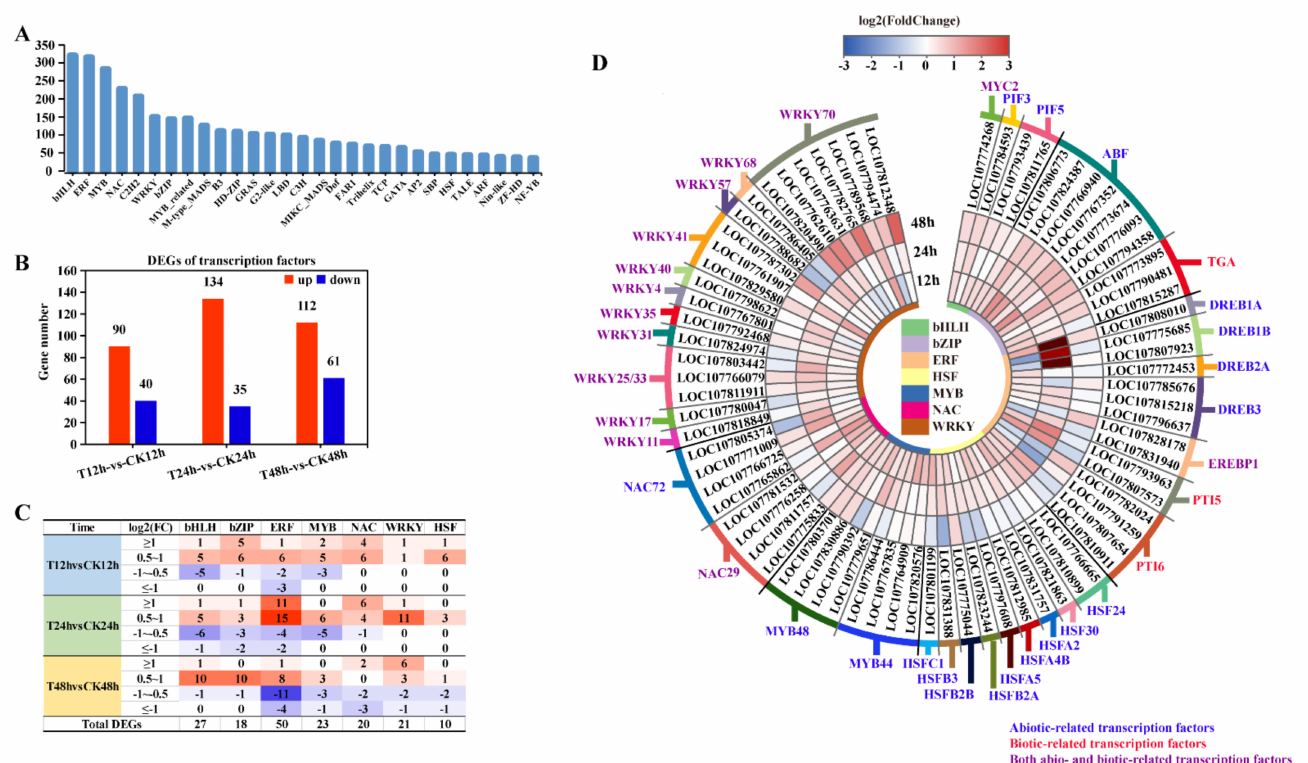
Figure 7. The expression of transcription factors that responded to 1 (cid:48) ,4 (cid:48) - trans -diol-ABA treatment at different time points. ( A )The TF families detected in tobacco; ( B ) The number of up- or down-regulated transcription factors. The statistical standard of DEGs was the FDR < 0.05, log 2 (Fold Change) > 0.5 was up and log 2 (Fold Change) < − 0.5 was down. ( C ) The number of major TF family members classified according to the level of fold change; Red colors represent up-regulated, blue colors represent down-regulated; The darker the color, the more the number; ( D ) Heat-map differential expression of the TFs in the major families involved in the regulation of resistance to biotic or abiotic stresses. The inner circle colors represent the different families, and the outer circle colors represent specific transcripts. The color of gene name shows the different labeling about biotic and abiotic stress related